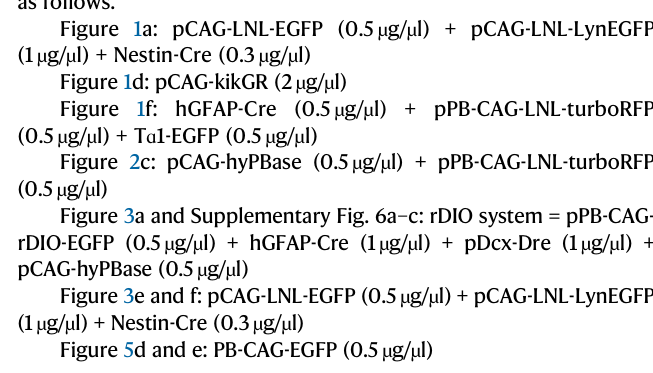
Figure 3e and f: pCAG-LNL-EGFP (0.5 µ g/ µ l) + pCAG-LNL-LynEGFP Figure 5d and e: PB-CAG-EGFP (0.5 µ g/ µ